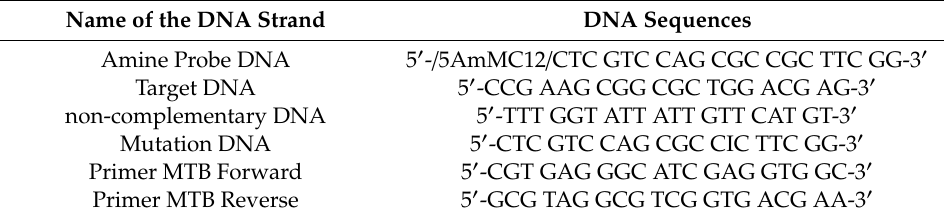
Table 2. Oligonucleotide sequences used in this